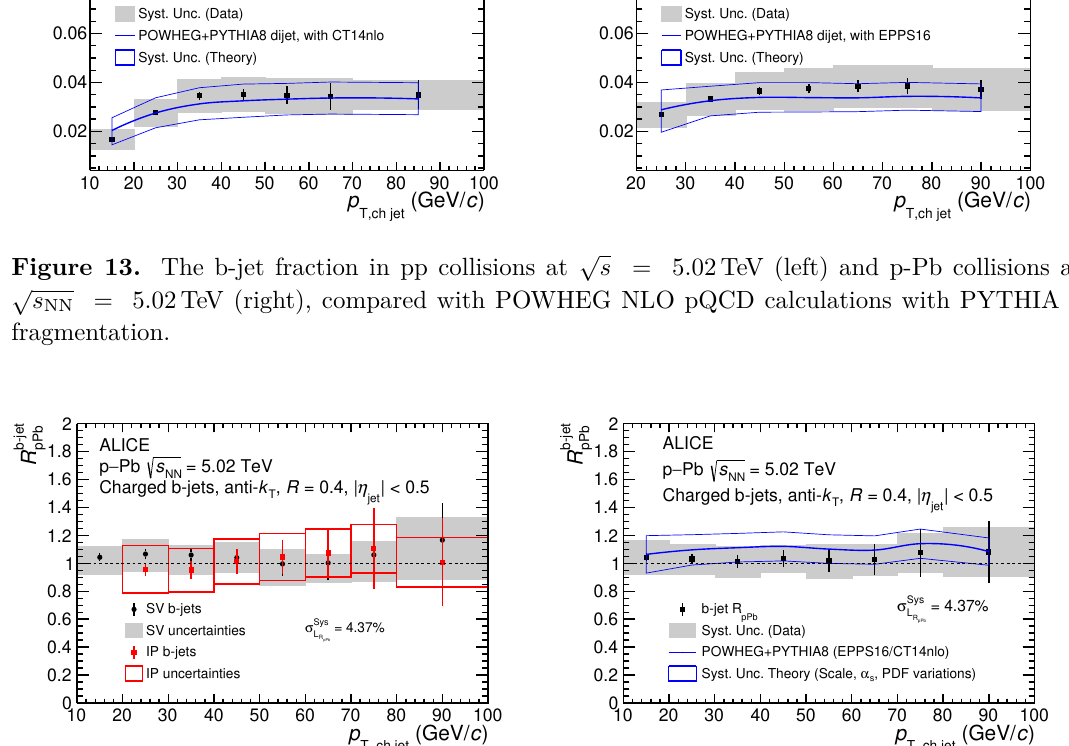
Figure 14. Left: the nuclear modification factor R b-jet of the inclusive charged-particle anti- k T pPb R = 0 . 4 b jets as a function of p T from the IP and SV method. Right: the nuclear modification factor R b-jet obtained from combining the IP and SV method results as a function of p T , chjet compared pPb with the calculation by the POWHEG dijet tune with the PYTHIA 8 fragmentation [77, 78]. Systematic and statistical uncertainties are shown as boxes and error bars, respectively. There is an additional normalization uncertainty of 4 . 37% due to luminosity, which is quoted